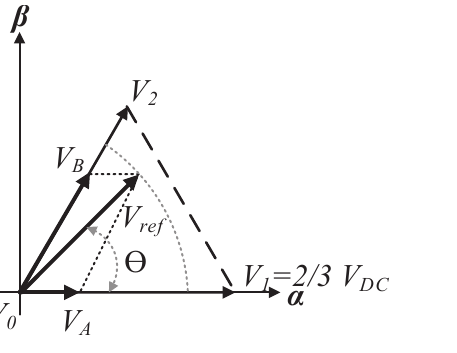
Figure 4. Analysis of V ref at the Sector